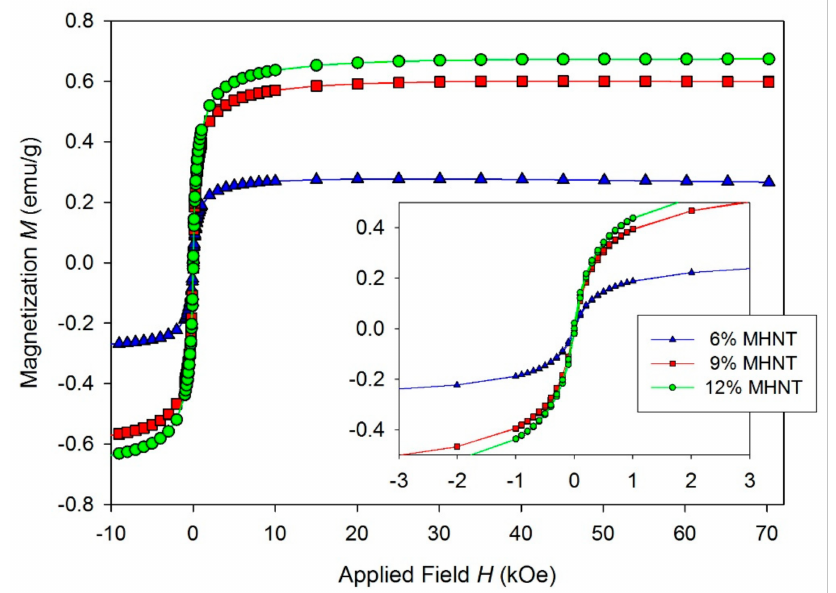
Figure 10. Isothermal hysteresis loops of PCL/Gel with 6.0 wt.% MHNT (triangle), PCL/Gel with 9.0 wt.% MHNT (square), and PCL/Gel with 12.0 wt.% MHNT (circle). Inset is the low field part of the